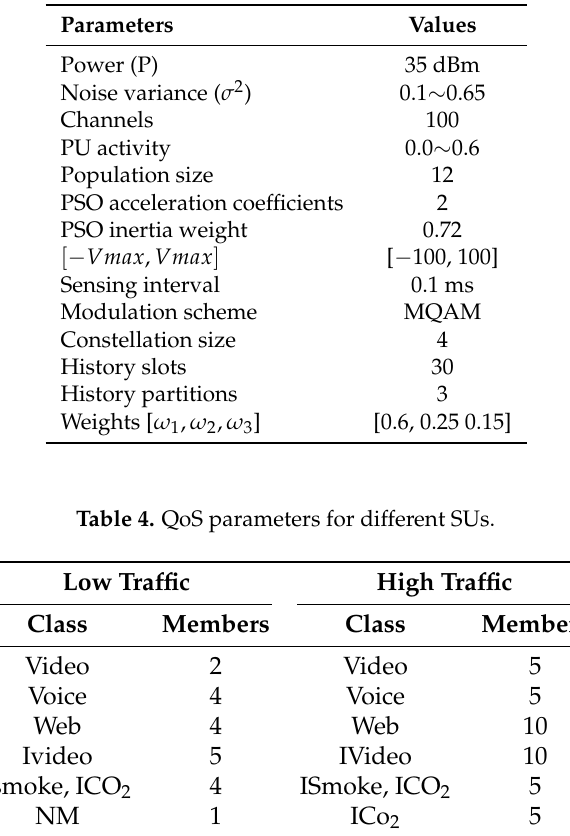
Table 3. Simulation parameters.